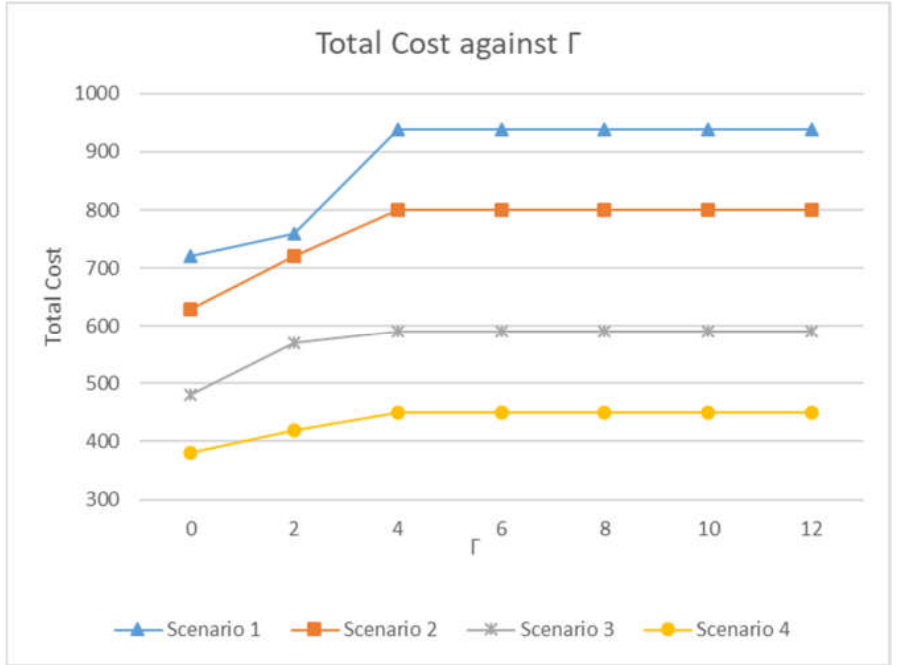
Figure 2. The trend of the total cost of opening consultation room and service overtime with respect to Γ and Cv k .